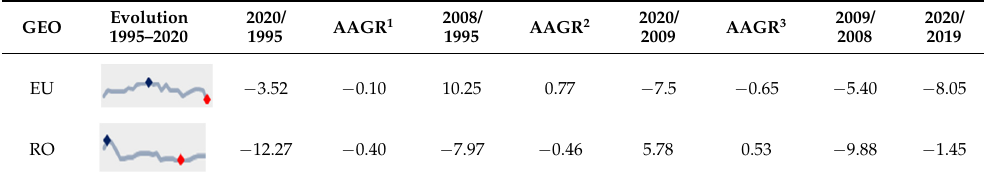
Table 2. Analysis of the final energy consumption evolution.